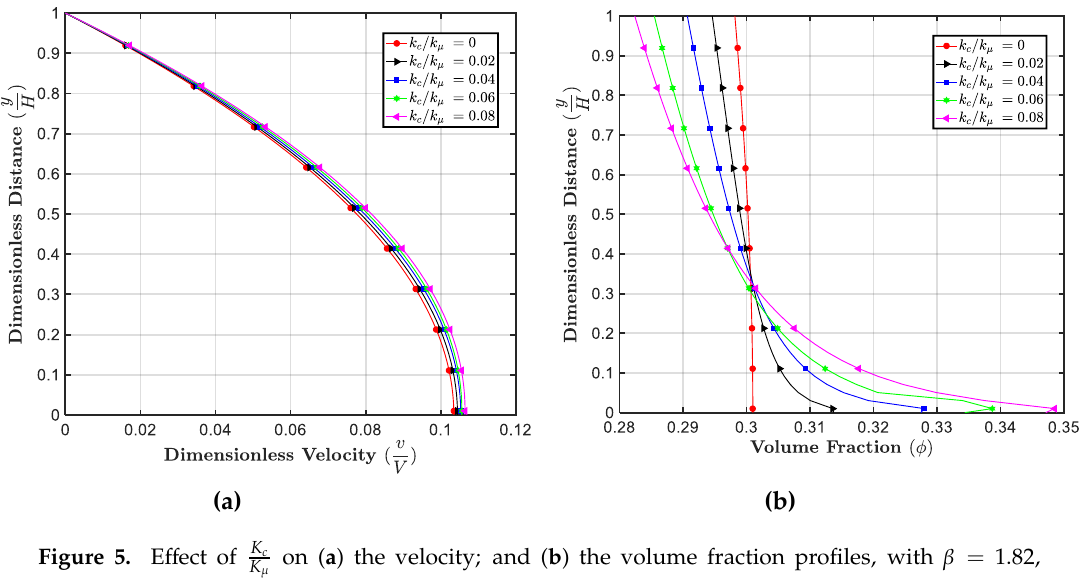
Figure 4. Distribution of the velocity for ( a ) ϕ = 0.65; and the cement volume concentration for ( f ) ϕ ϕ 𝑚 = 0.65. 0.60 ; ( j ) ϕ 𝑚